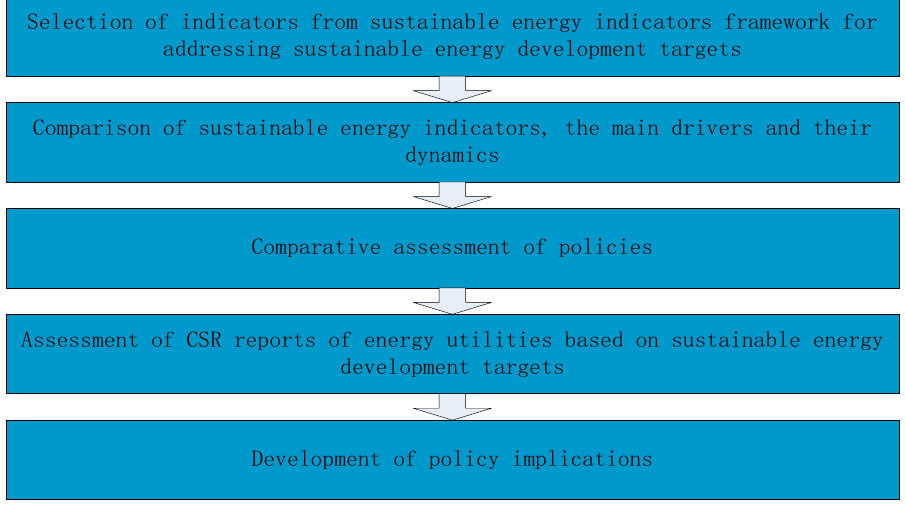
Figure 1. Methodology of the study. Source: created by the authors.